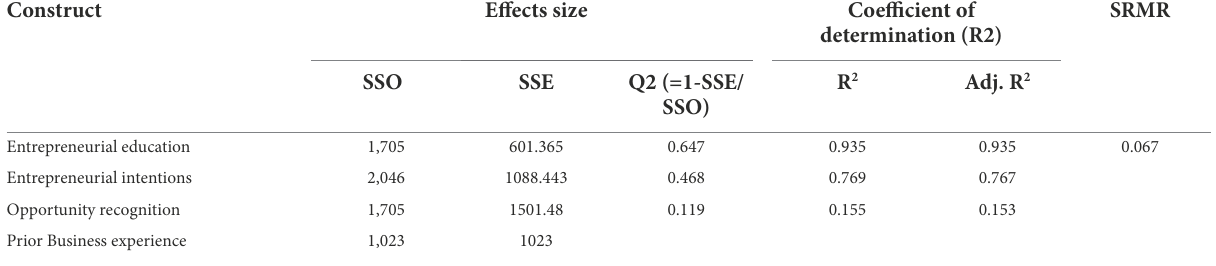
TABLE 6 Model strengths.